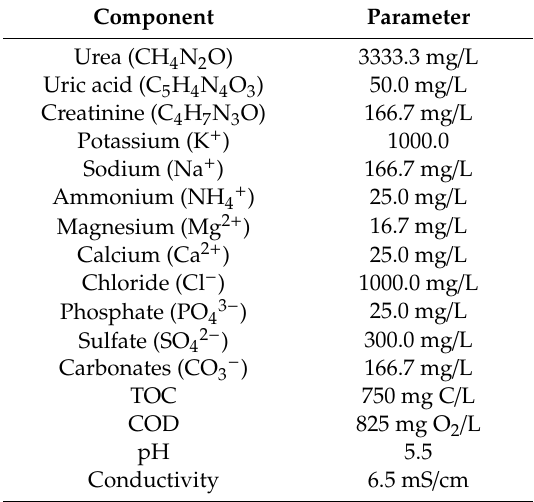
Table 1. Composition of synthetic urine and its physicochemical